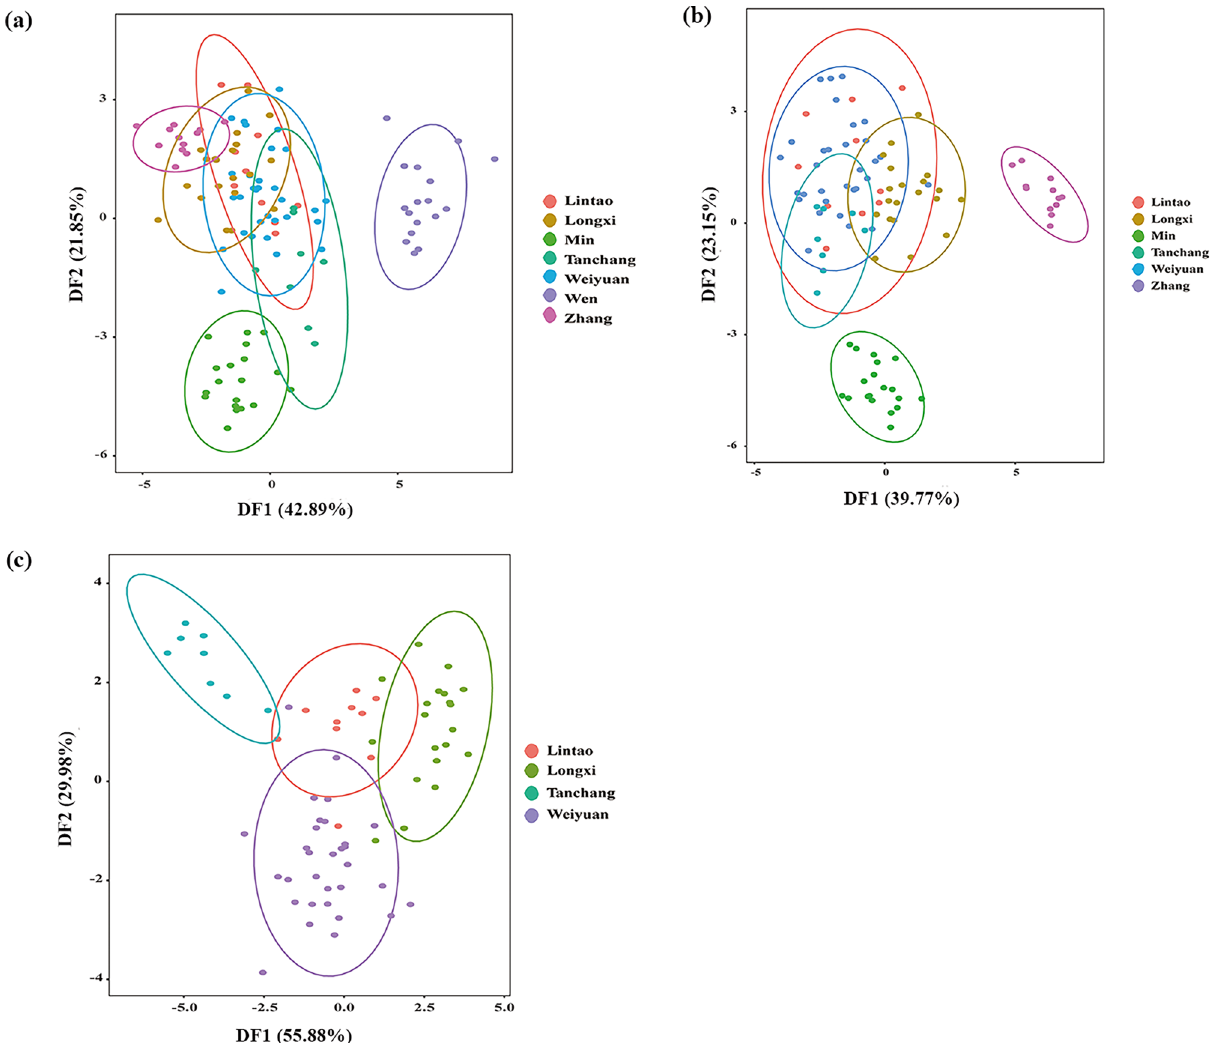
Figure 3. Scatter plot of the first two discriminant functions of linear discriminant analysis of Codonopsis Radix samples according to their geographical origin. ( a ) data from all regions, ( b ) data from Lintao, Weiyuan, Longxi, Min, Zhang and Tanchang, ( c ) data from Lintao, Weiyuan, Longxi and